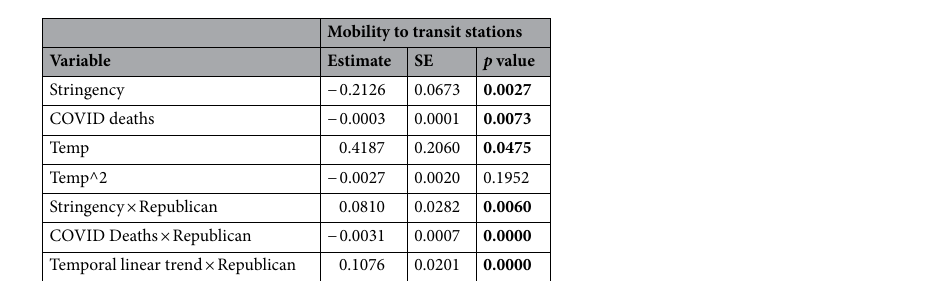
Table 1. Parameter estimates, standard errors (SE) and p values from our main model (with mobility to transit stations as the dependent variable). Significant values are in